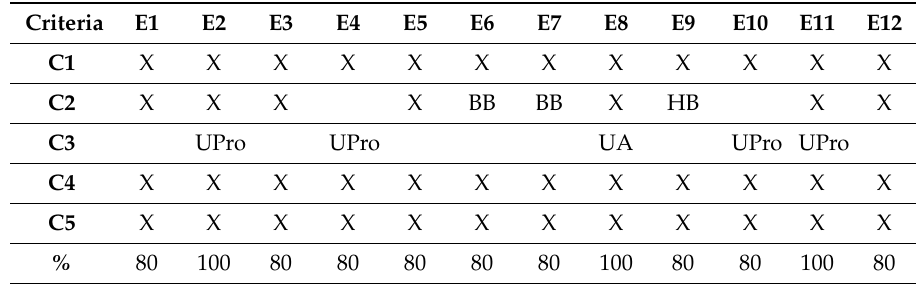
Table 1. Inclusion criteria fulfilled by the